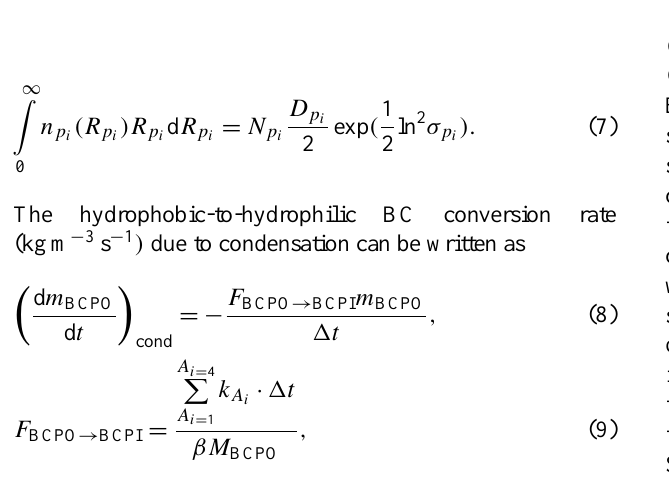
Fixed aging (FIX) e -folding BC aging time τ fix = 1 . 2 days Standard microphysics- D BC = 60 σ BC = 1 . 8